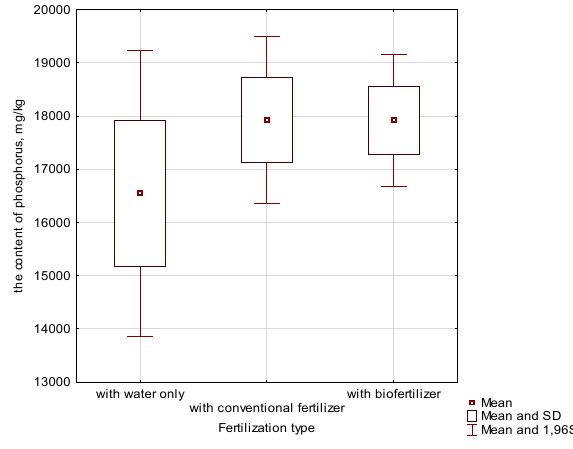
Figure 4: The content of phosphorus in